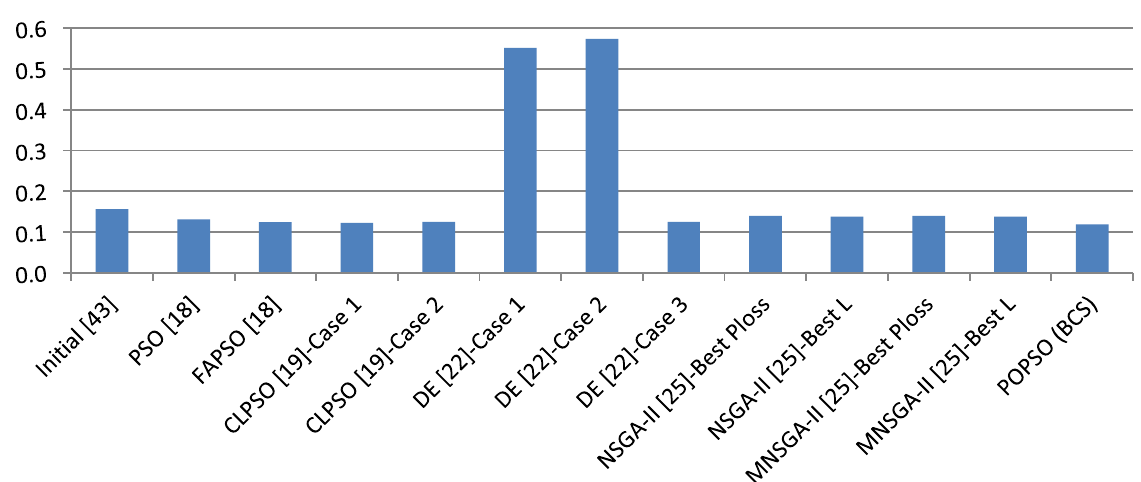
Figure 11. Comparison results of L- index in IEEE 30-bus test system